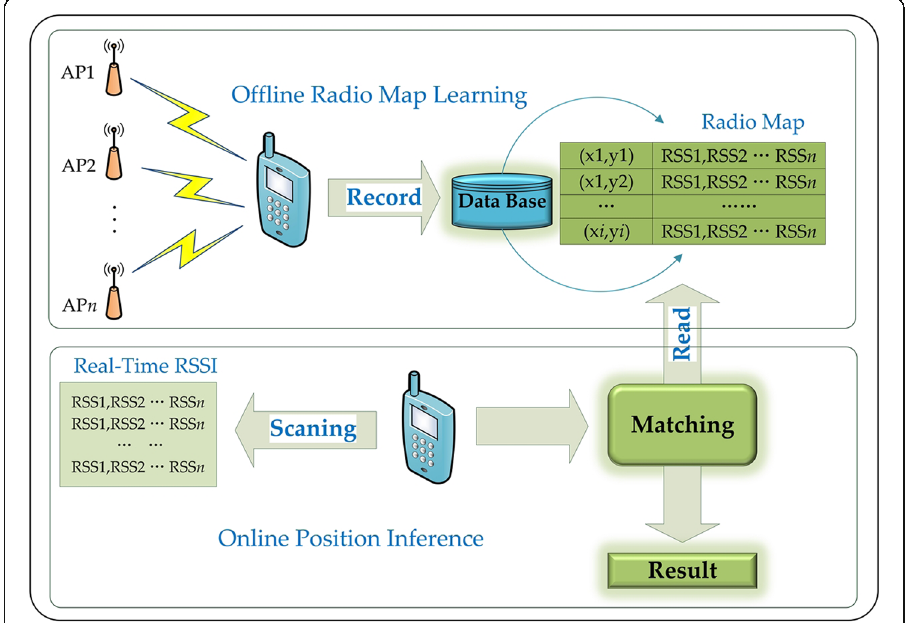
Fig. 2 WiFi fingerprinting positioning